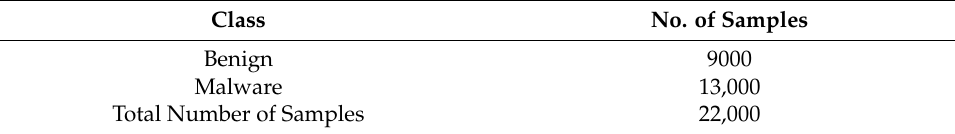
Table 1. Details of the